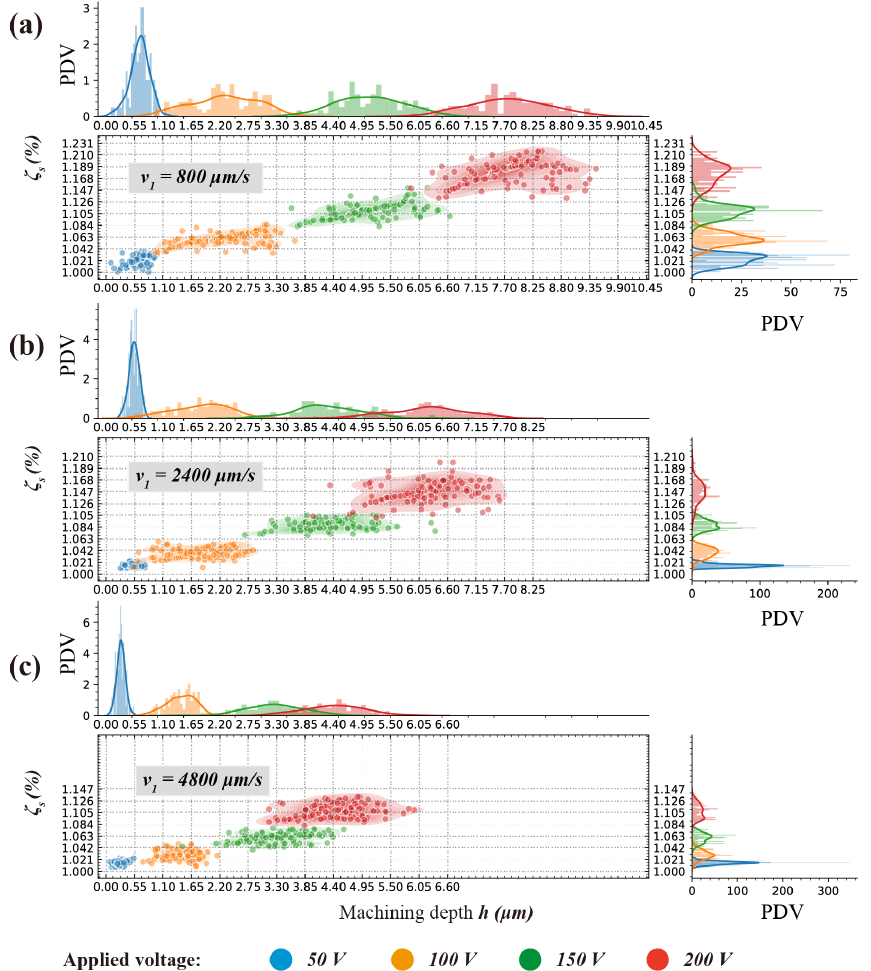
Figure 8. Effect of applied voltage U and nozzle travel speed v on the similarity ratio ζ s and machining depth h of micro letters. ( a ) v 1 = 800 µ m/s; ( b ) v 2 = 2400 µ m/s; ( c ) v 3 = 4800 µ